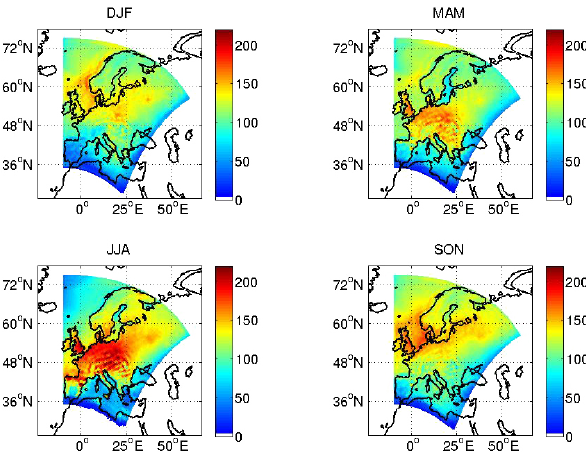
Figure 3. Averaged aerosol number concentrations in the accumu- lation mode (cm − 3 ).